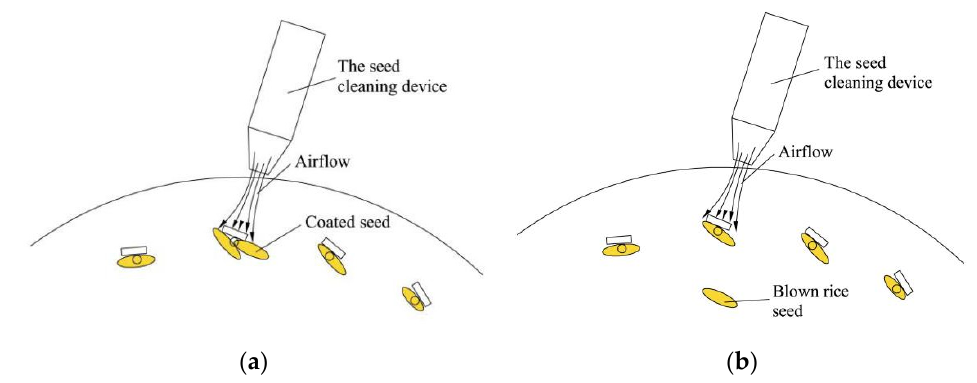
Figure 5. Schematic diagram of the air cleaning process: ( a ) before removing the seed; ( b ) after removing the